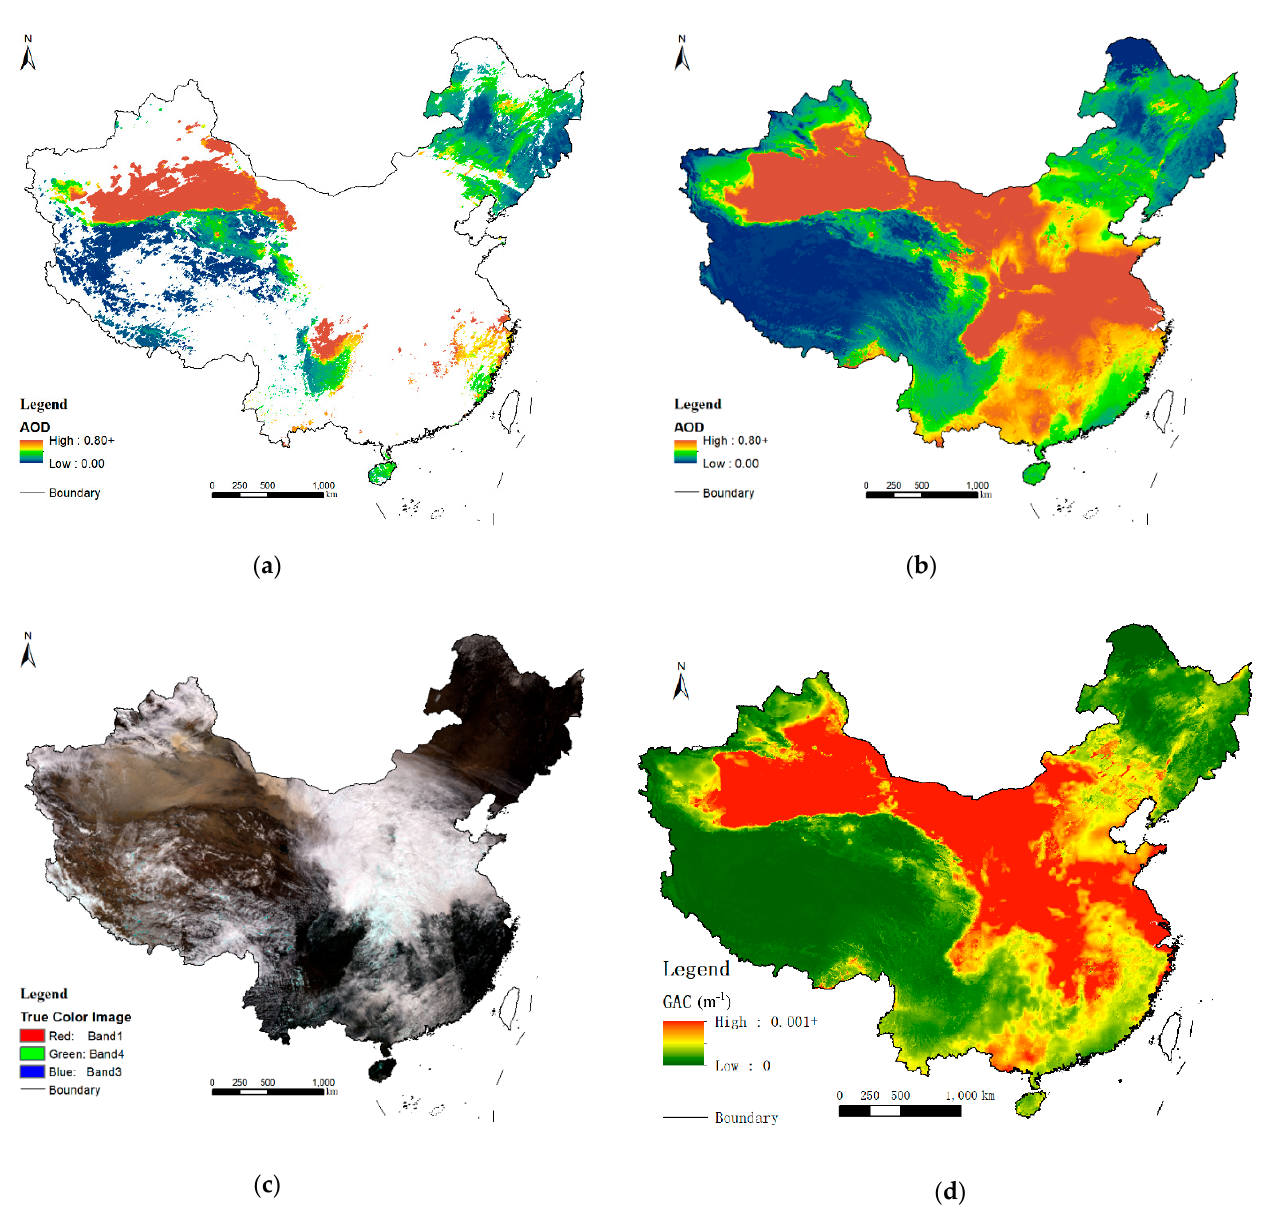
Figure 9. Imputation of MAIAC AOD for a spring day (1 April) of 2015: original AOD ( a ), complete AOD ( b ), MAIAC ground reflectance of true color ( c ) and GAC ( d ).